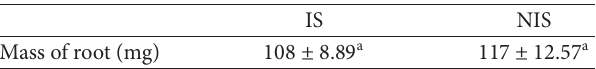
Table 2: Weight of root at harvest (average of three plants on dry matter basis). IS